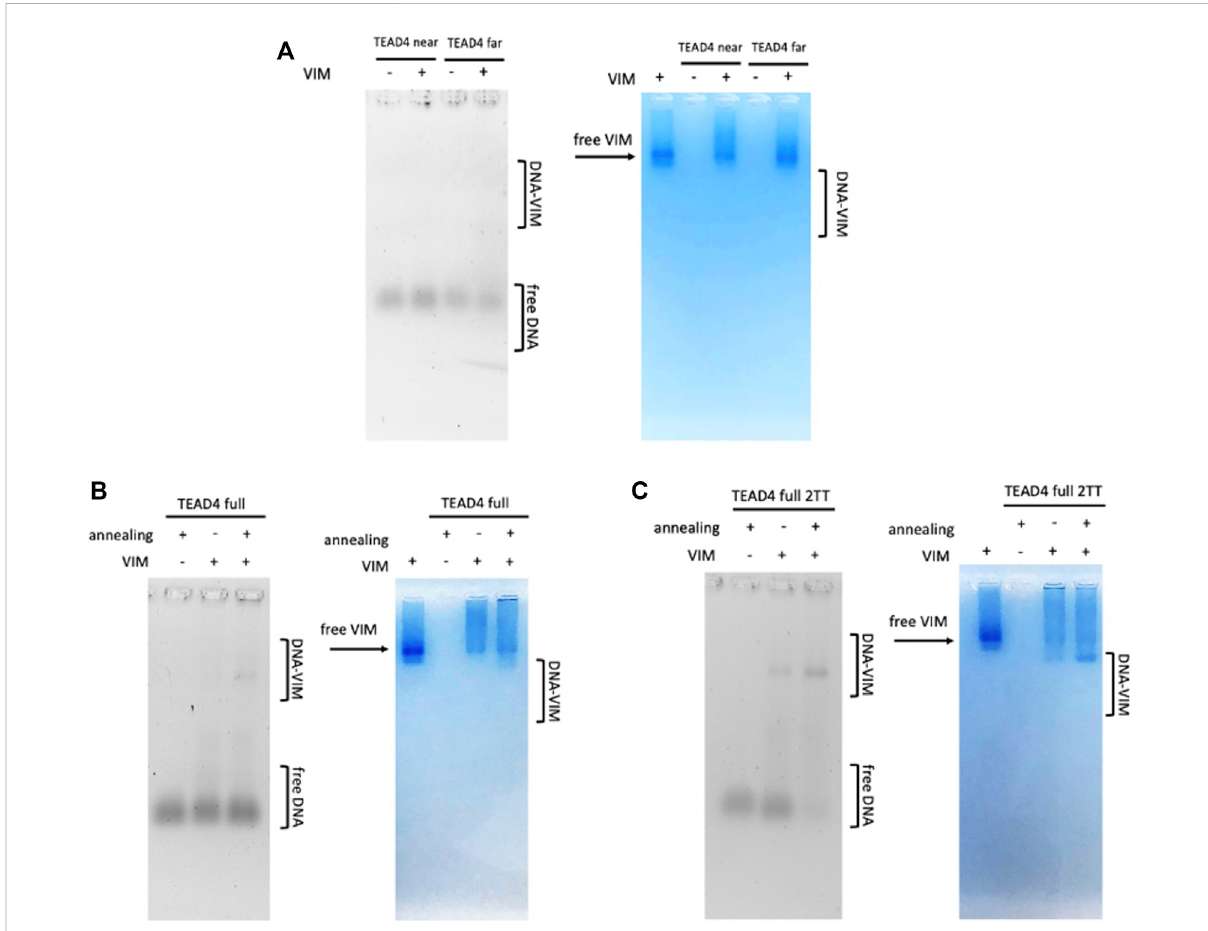
FIGURE 7 EMSA of tested oligonucleotides (500 nM) incubated with 8 µM Vimentin in 5 mM Tris, pH 8.4, 150 mM KCl, stained with Sybr Green II (on the left) and Coomassie Brilliant Blue G250 (on the right) Panel (A) TEAD4-near and TEAD4-far; Panel (B) TEAD4-full before and after annealing in presence of KCl; Panel (C) TEAD4-full-2TT before and after annealing in presence of